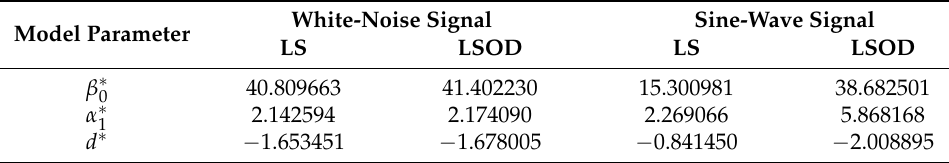
Table 1. Parameter identification of the servo system model (44).